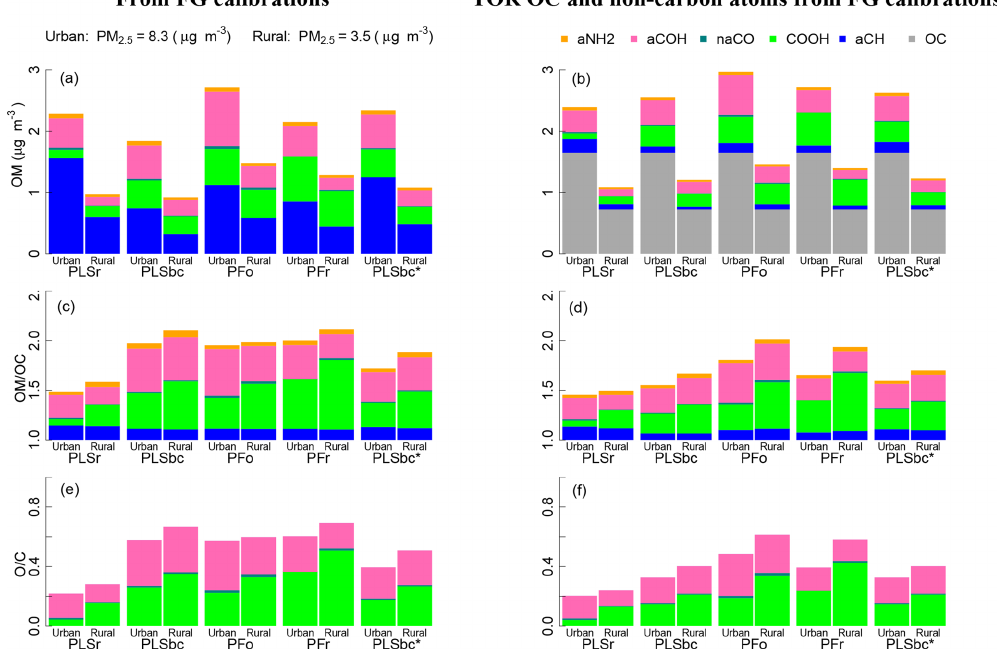
Figure 10. (a, b) bar plots of OM mass fractions from quantified FGs. (c, d) bar plots of OM / OC ratio and associated non-carbon atoms. (e, f) O / C. In the left panels (a) , (c) , and (e) OM, OM / OC and O / C ratios use OC estimated by FG calibrations (FG OC). In the right panels (b) , (d) , and (f) the OM, OM / OC and O / C ratios use OC measured by TOR. PLSr and PLSbc refer to partial least square using raw and baseline-corrected spectra respectively. PFo and PFr refers to peak fitting using the original recalibrated absorption coefficients. PLSbc* is the same as PLSbc except that the number of LVs for aCH has been selected heuristically (Sect.